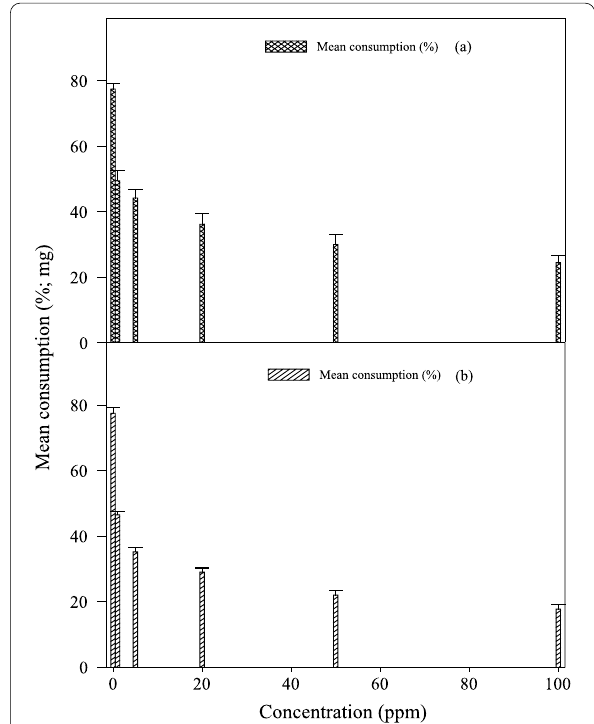
Fig. 10 Activity of copper nanoparticles against Heterotermes indicola